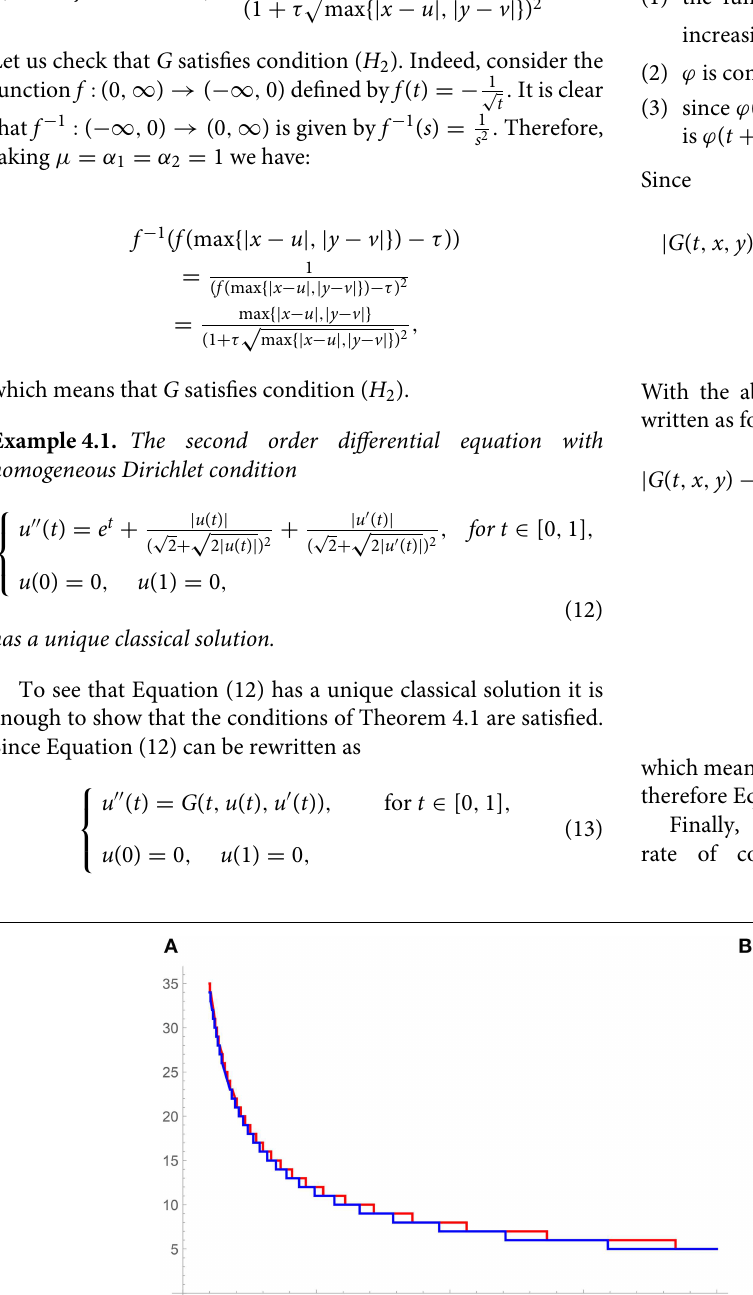
0 , while 8 2 corresponds to u 1 =